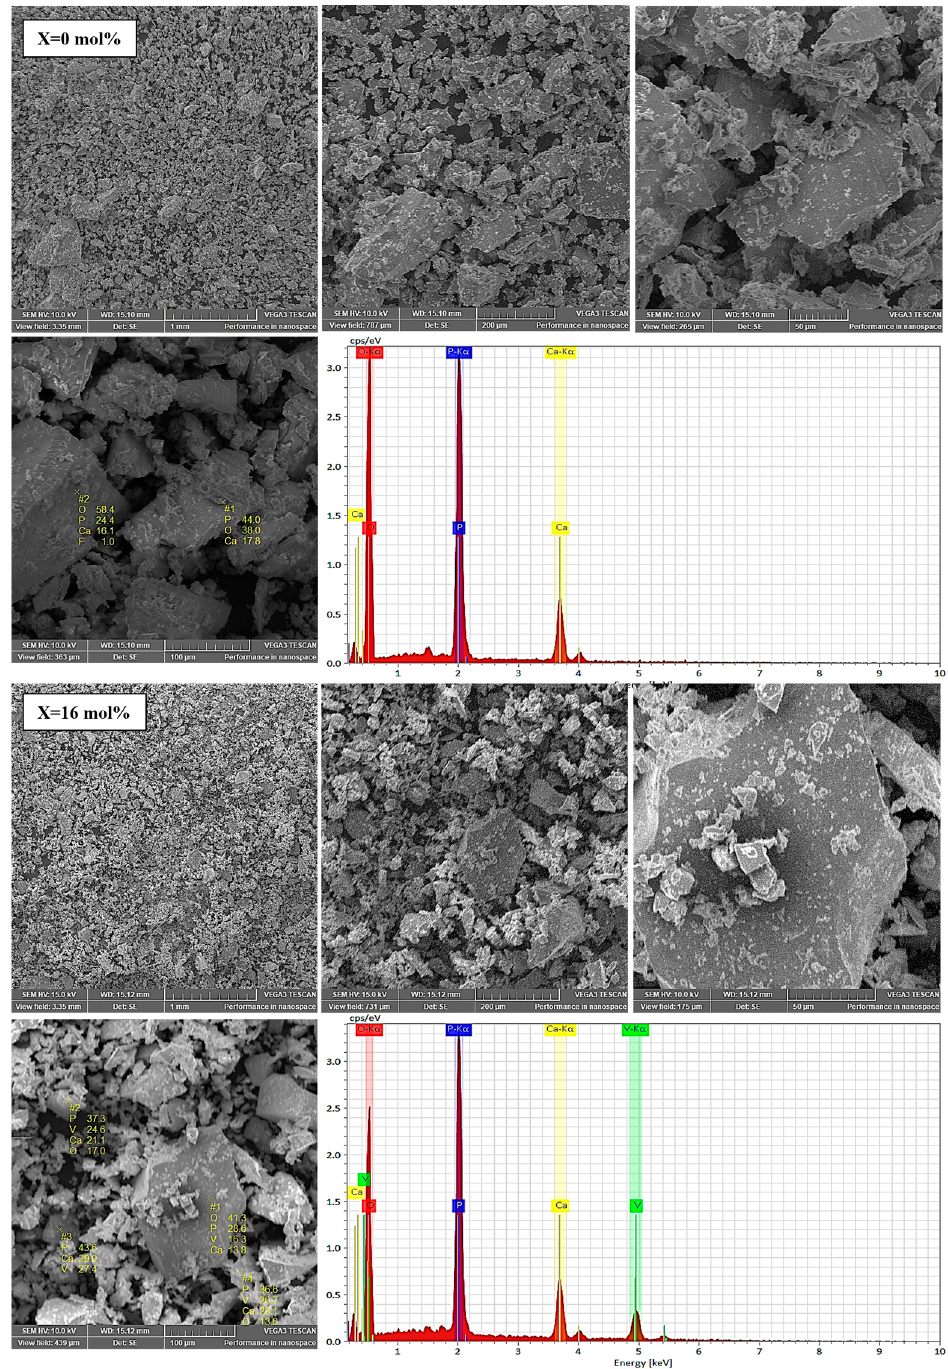
Figure 3. SEM micrographs and EDS analysis for glass samples with x = 0 and 16 mol% V 2 O 5 used in the dissolution experiments. Colour legend: O (red), Ca (yellow), V (green) and P (blue). Table 1. The chemical elements present in the surface of glass powders evaluated by EDS spectros- copy.